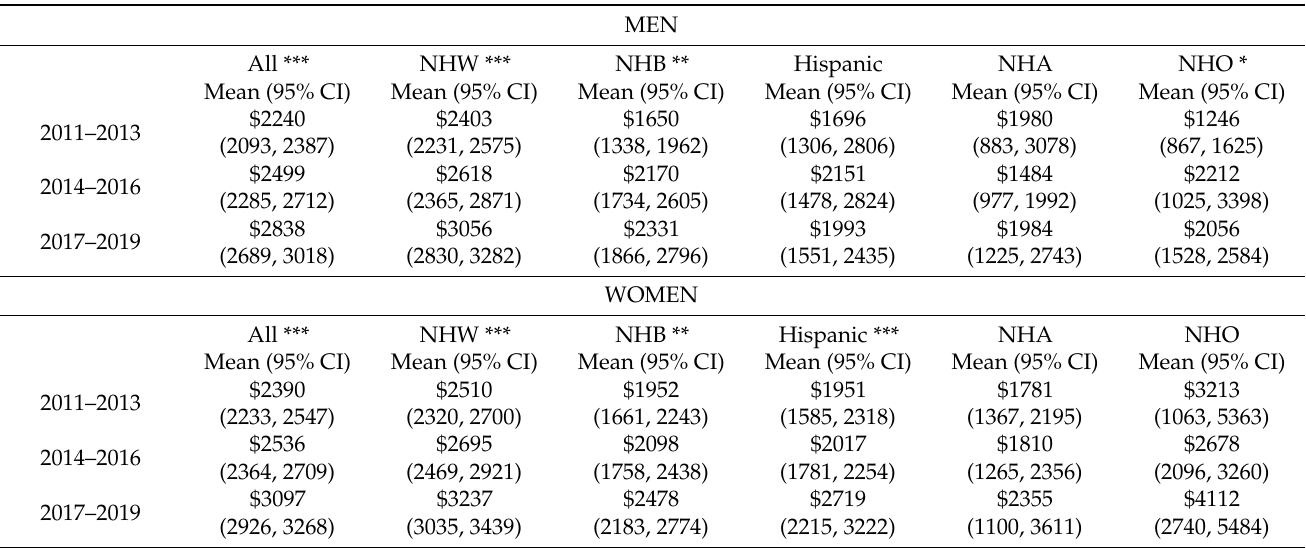
Table 2. Unadjusted mean office-based expenditure overall and by race and ethnicity among men and women with arthritis: United States 2011–2019.